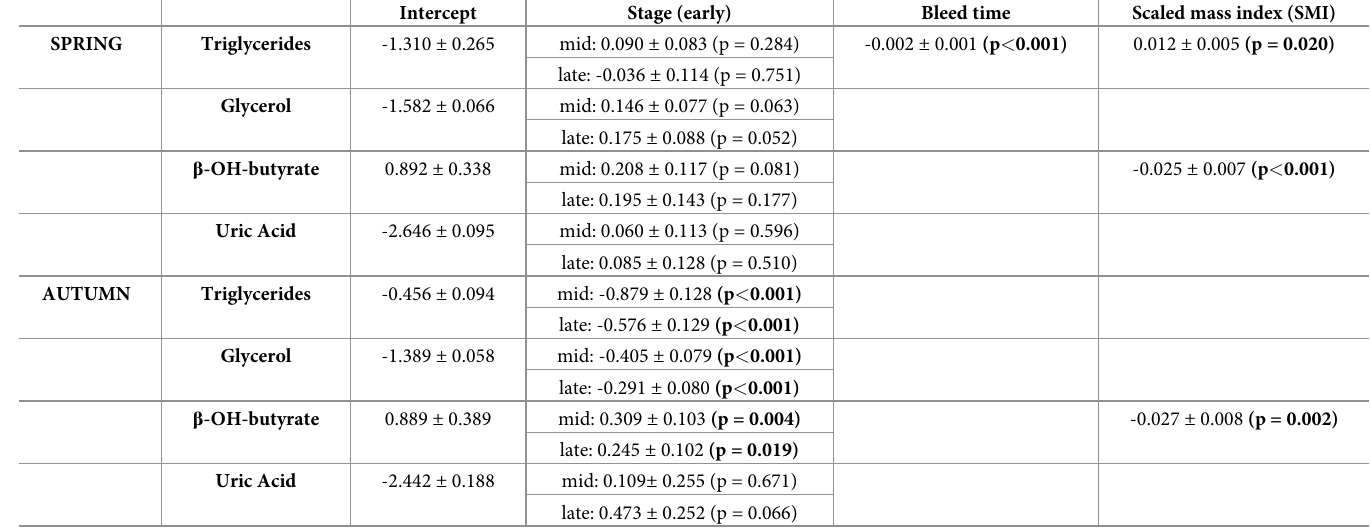
Table 1. Results of the minimum adequate model derived by comparison of nested generalized linear models explaining variation in plasma metabolite concentra- tions of migrant dunlins across stages (early, mid and late) in spring and autumn migratory periods.